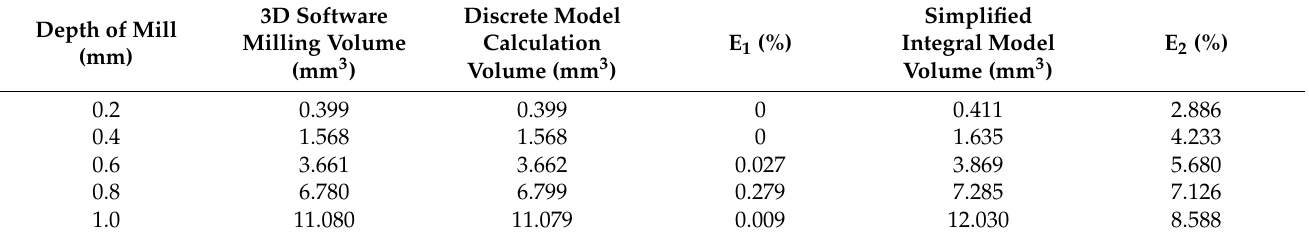
Table 2. Comparison of milling